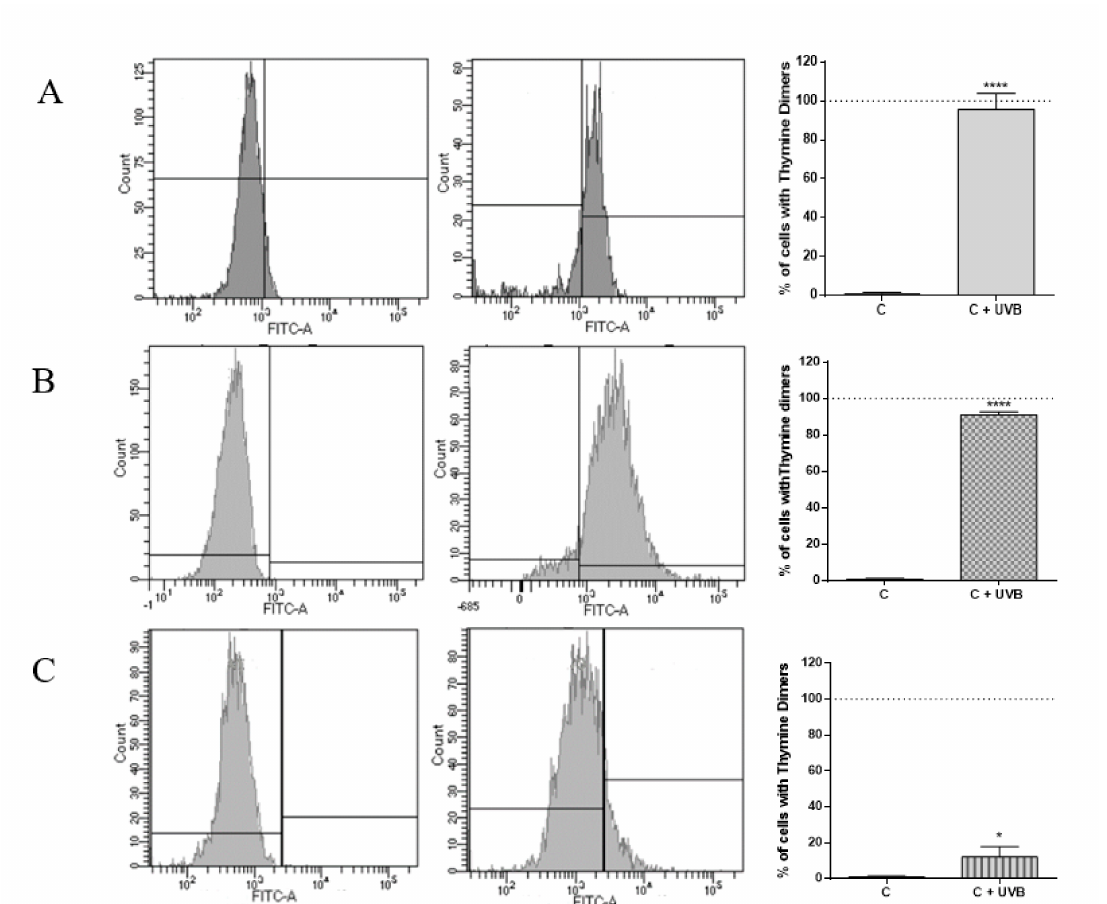
Figure 1. Histograms of one sample of each group included in the experiment, non-irradiated (left histograms) or irradiated with 0.04 J / cm 2 UVB (right histograms), and Barr graph showing the percentage of thymine dimers generated in each condition for HaCat culture cells ( A ), RHE ( B ) and medaka embryos ( C ). C—control samples and C + UVB—control samples irradiated with UVB. * p < 0.05; **** p <